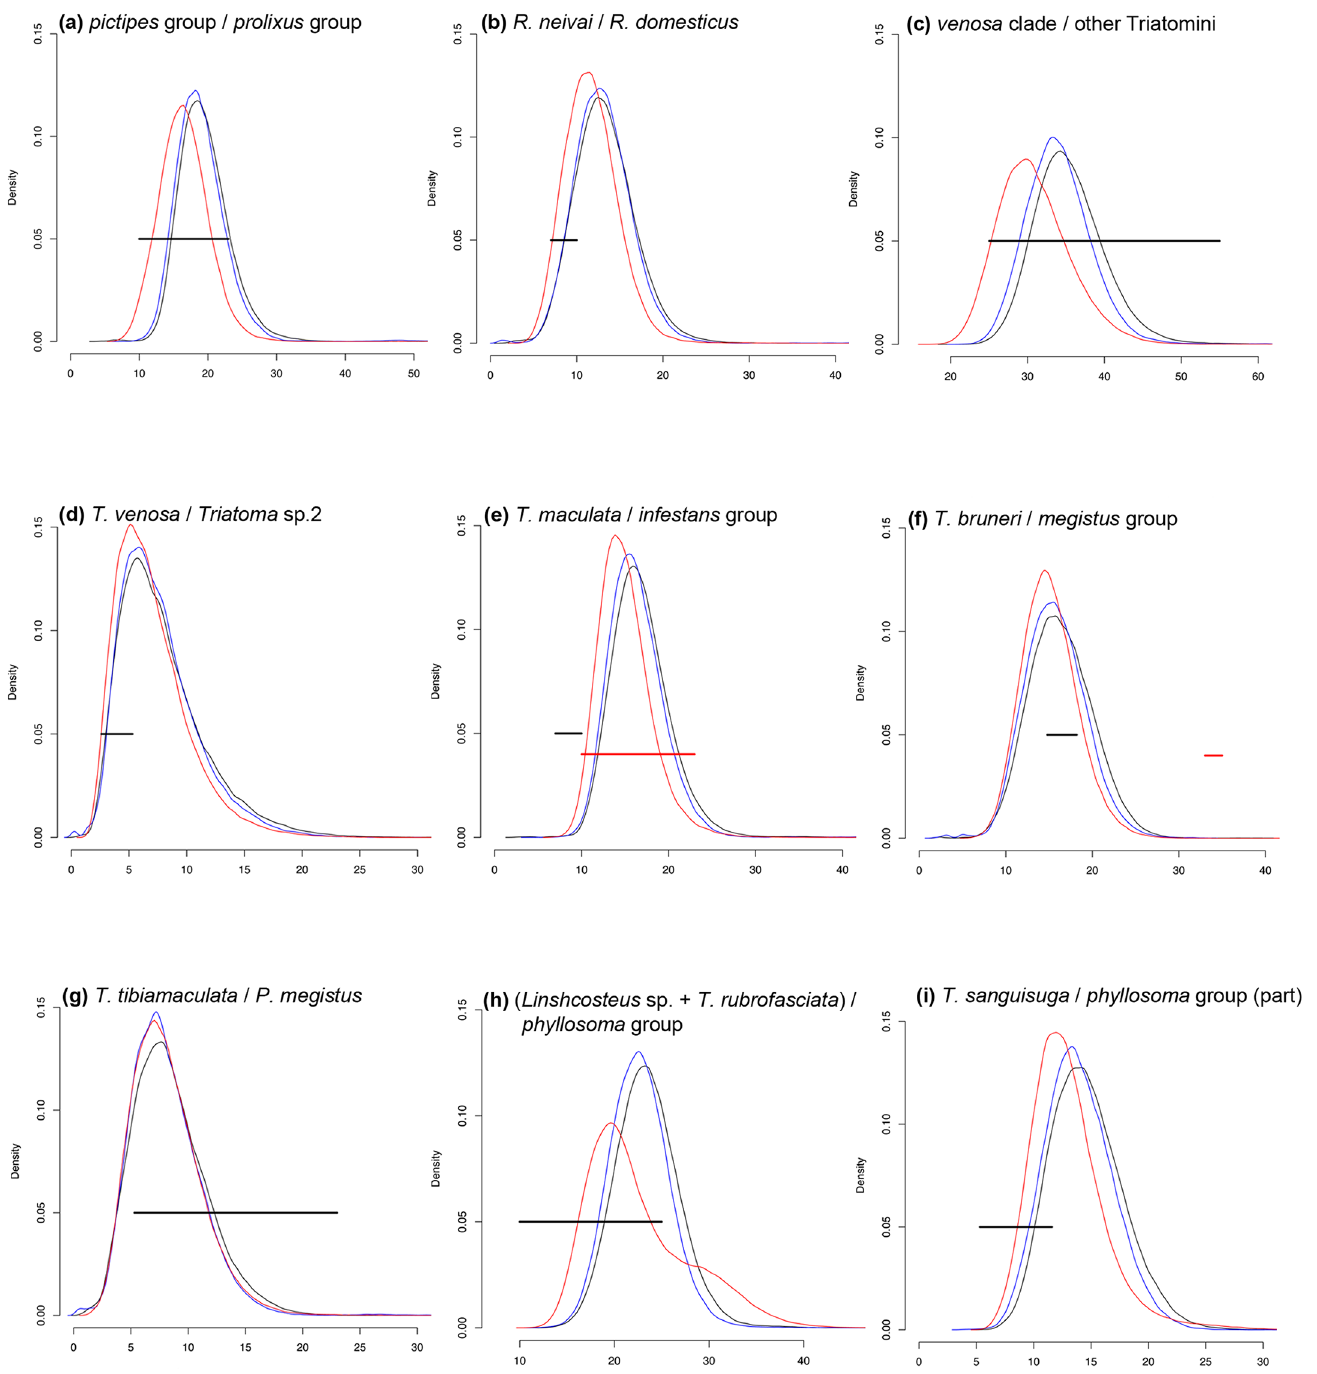
Fig 3. Vicariant events (black and red horizontal lines) plotted against posterior distribution (95% HPD) estimated for the nodes. (a) pictipes group / prolixus group – Pebas System; (b) R . neivai / R . domesticus – Acre System; (c) venosa clade / other Triatomini – Western Cordillera uplift; (d) T . venosa / Triatoma sp. 2 – last Andean uplift; (e) T . maculata / infestans group – Pebas System (red horizontal line) and Acre System (black horizontal line); (f) T . bruneri / megistus group – GAARlandia (red horizontal line) and rafting with Capromyinae (black horizontal line); (g) T . tibiamaculata / P . megistus – old Amazonian- Atlantic Forest pathway; (h) ( Linshcosteus sp. + T . rubrofasciata ) / phyllosoma group – Bering Land Bridge; (i) T . sanguisuga / phyllosoma group (part) – high sea level. Red distribution line refers to the estimates using one fossil calibration (B1); blue distribution line refers to the estimates using six fossil calibrations (B2); black distribution line refers to the estimates using seven fossil calibrations (B3). The vicariant events tested and the corresponding geological events are the following: